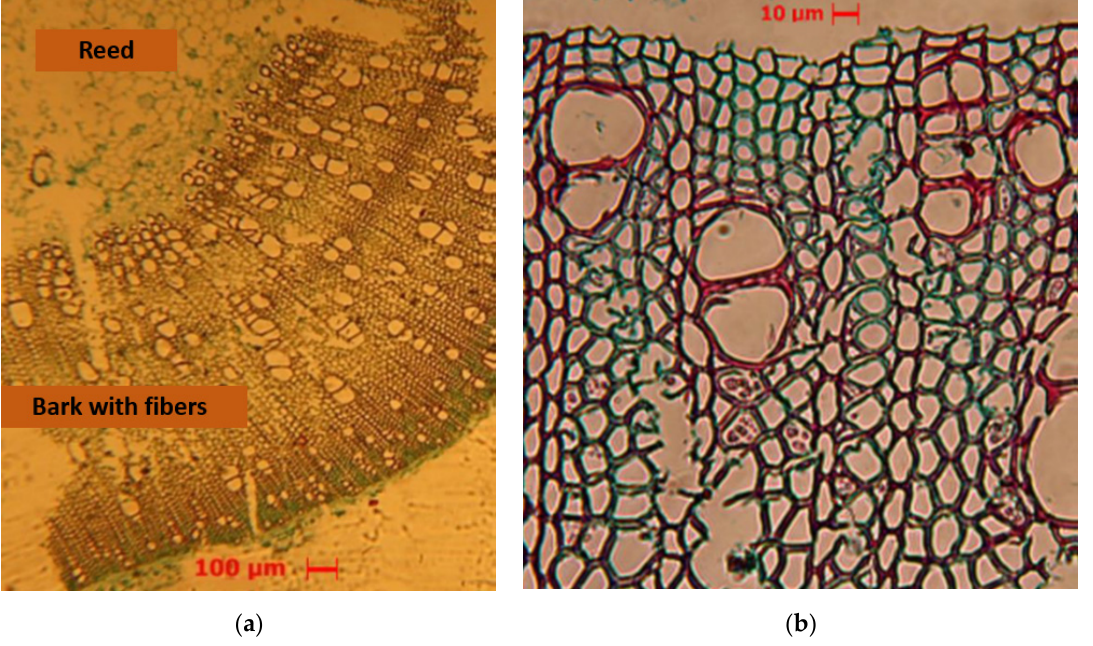
Figure 3. Scanning electron microscopy (SEM) in a bentonite sample: ( a ) variability of grain size; ( b ) surface appearance.